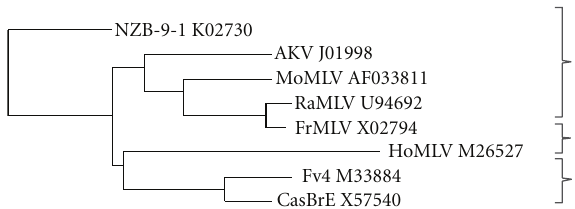
Figure 3: Phylogenetic tree of the Env genes of E-MLV gam- maretroviruses. The tree includes laboratory mouse isolates FrMLV, MoMLV, and Rauscher MLV (RaMLV), the naturally occurring viruses AKV MLV, CasBrE, and HoMLV, and the Env gene of the Fv4 restriction gene. The three related groups are bracketed. Sequences from GenBank were aligned using ClustalW2 and used to generate neighbour-joining trees. The X-MLV NZB-9-1 was included to root the